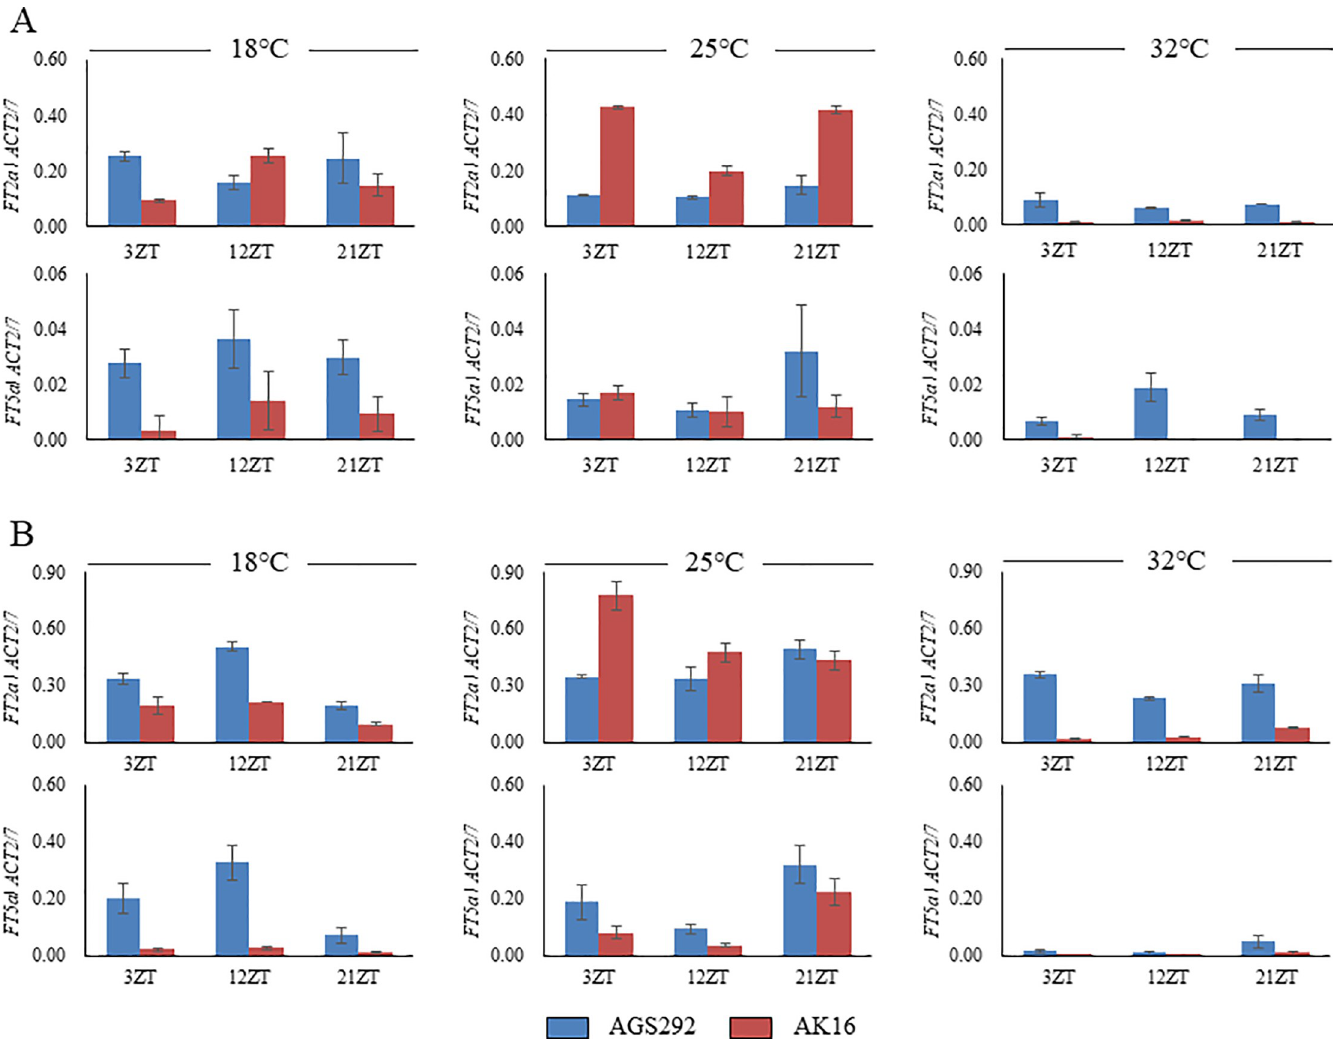
Fig 7. Expression profiles of FT2a and FT5a in soybean lines AGS292 and AK16 under different thermal conditions. (A) Second trifoliate-leaf stage, (B) Fourth trifoliate-leaf stage.